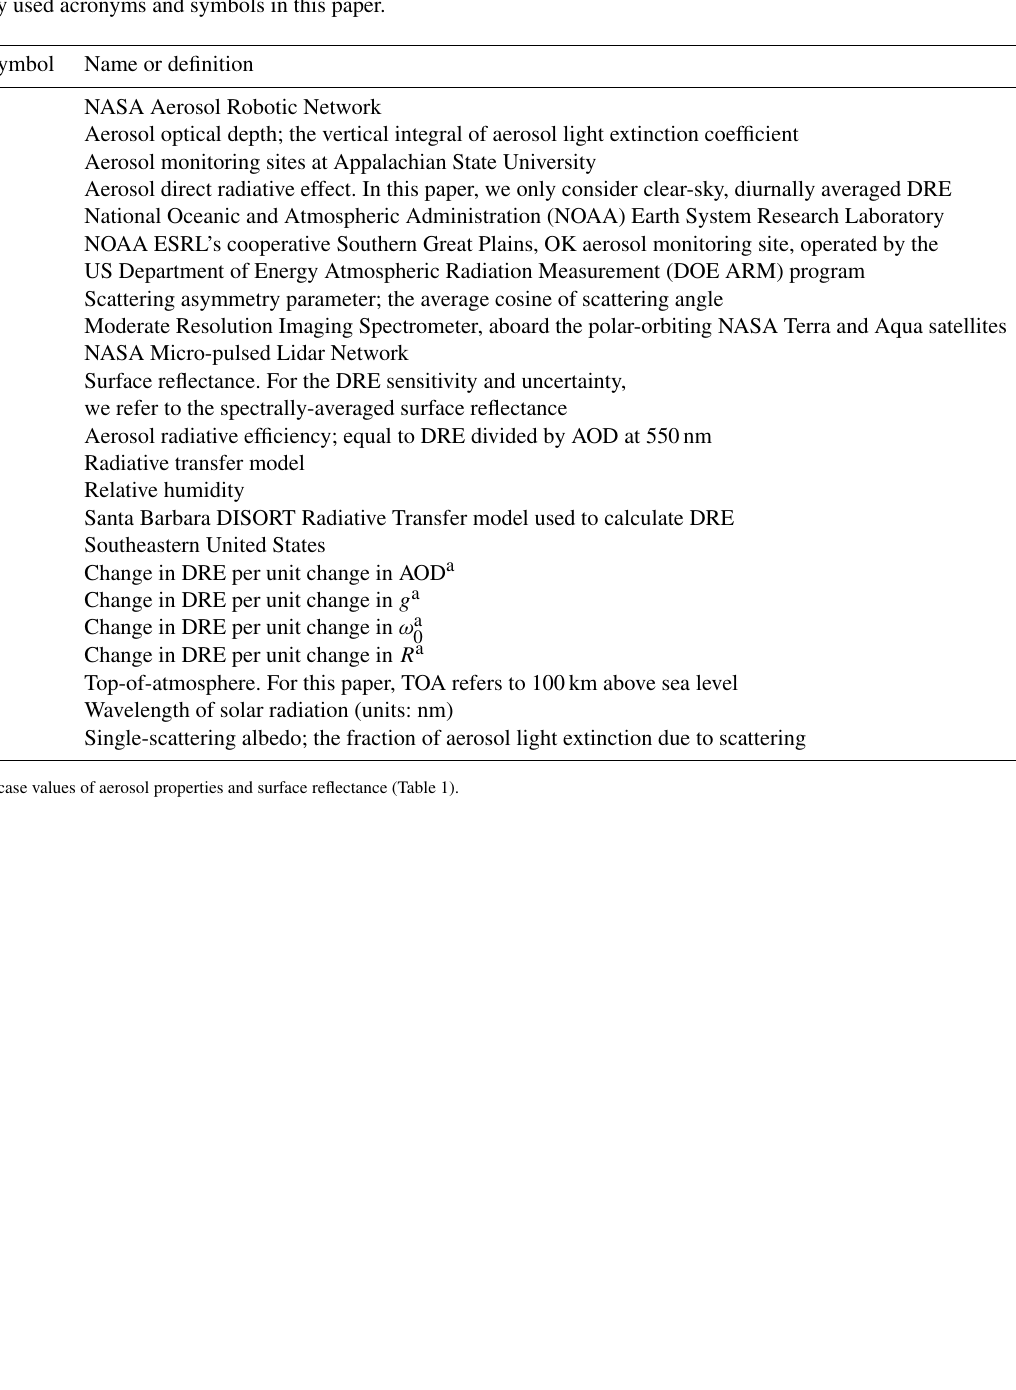
Table A1. Frequently used acronyms and symbols in this